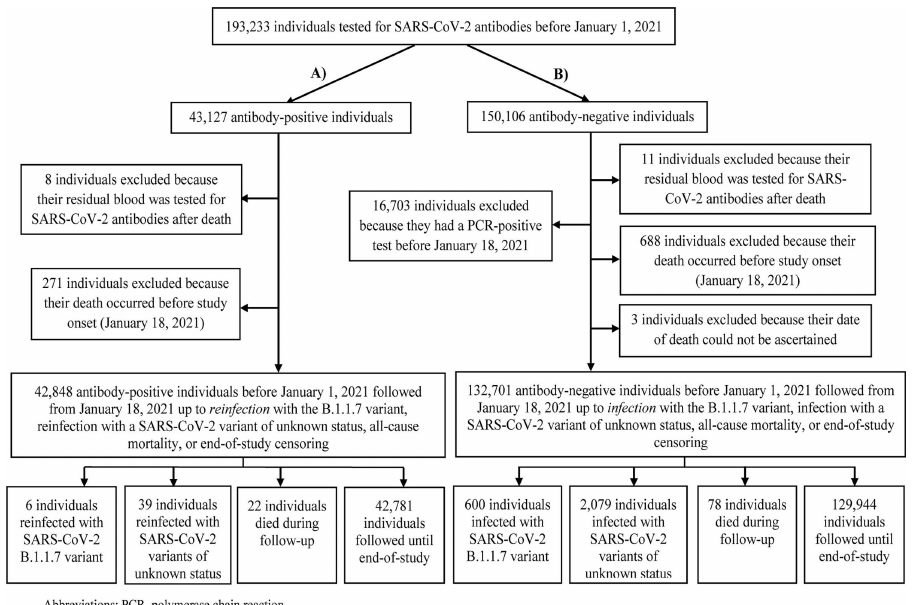
Fig 4. Flow chart of SARS-CoV-2 reinfections with B.1.1.7 and variants of unknown status in the national cohort of antibody-positive individuals and the national cohort of antibody-negative individuals. (A) Antibody-positive individuals. (B) Antibody-negative